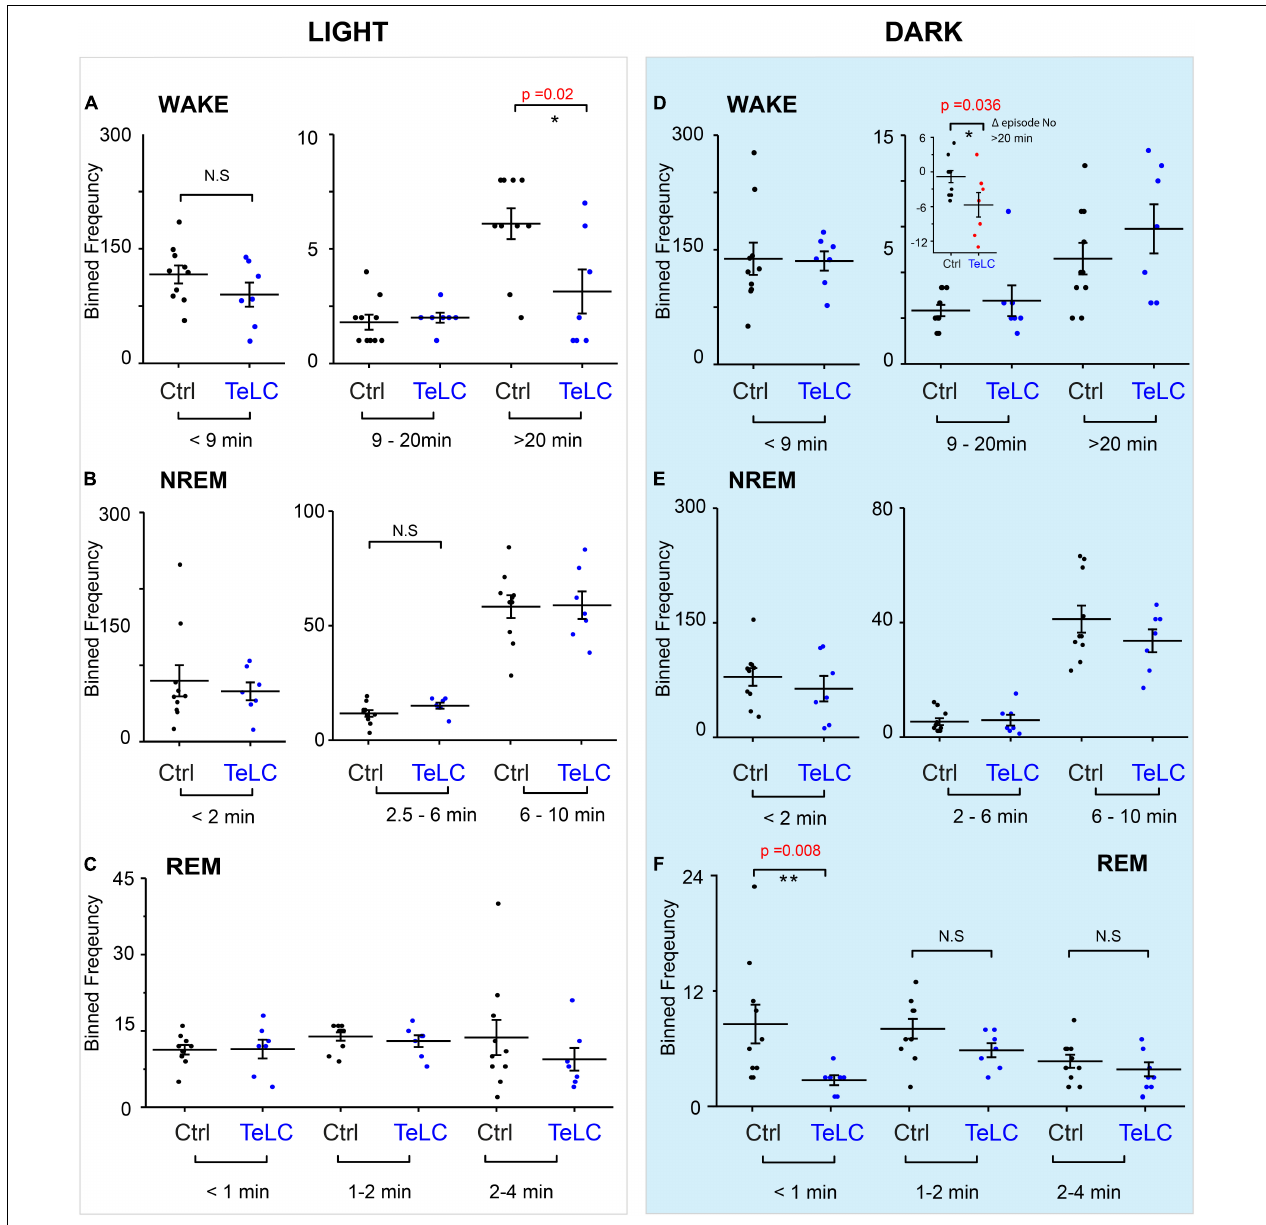
FIGURE 4 | Distribution of sleep episode lengths is reduced for Nos1-MnPO/MPO-GFP-TeLC mice during wakefulness in the light period but increased in wakefulness in the dark period. (A) Wakefulness in the light period binned by episode length. No differences are seen in bins less than 20 min. Episodes greater than 20 min in Nos1 - MnPO/MPO-GFP-TeLC mice ( n = 7 TeLC and n = 10 GFP, p = 0.02). (B) NREM in the light period binned by episode length. No differences are seen in bins less than 10 min ( n = 7 TeLC and n = 10 GFP). (C) Light phase REM. No differences are seen in bins less than 4 min ( n = 7 TeLC and n = 10 GFP). (D) Dark phase wakefulness. No differences are seen between groups within each light cycle ( n = 7 TeLC and n = 10 GFP). Inset graph, between the light periods Nos1 - MnPO/MPO-GFP and Nos1 - MnPO/MPO-GFP-TeLC groups as a paired difference (d, inset graph, n = 7 TeLC and n = 10 GFP, p = 0.036). (E) Dark phase NREM. No differences are seen in bins less than 10 min ( n = 7 TeLC and n = 10 GFP). (F) Dark phase REM. No differences are seen in bins greater than 1 min. Episodes of less than 1 min are significant between Nos1 - MnPO/MPO-GFP-TeLC and Nos1 - MnPO/MPO-GFP mice ( n = 7 TeLC and n = 10 GFP, p = 0.008). Multiple comparisons were accounted for using the Benjamini-Hochberg procedure at a false discovery rate of 5%. * P < 0.05, ** P < 0.01, N.S, not significant.